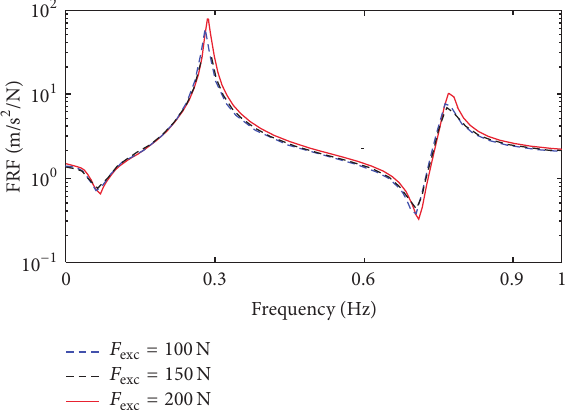
Figure 15: Comparison of frequency response functions for various excitation levels at torque = 8N ⋅